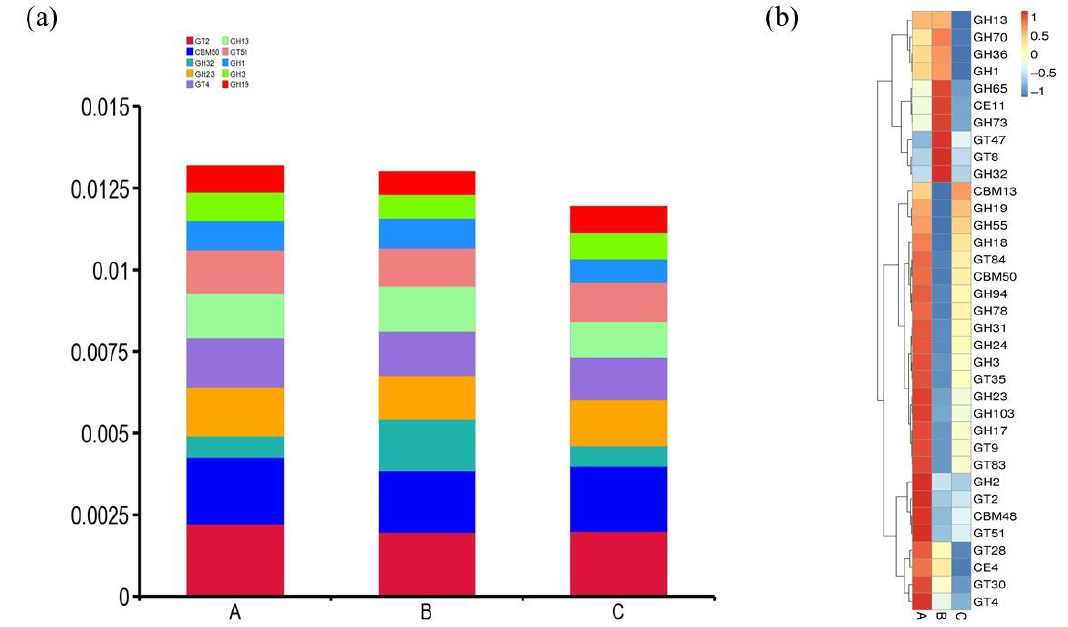
Figure 4. Comparative CAZymes analysis of metagenomic data sets of fermented suancai at different time points. ( a ) Percentage of top 10 CAZymes. ( b ) Relative abundance variations of CAZymes represented by a heatmap.